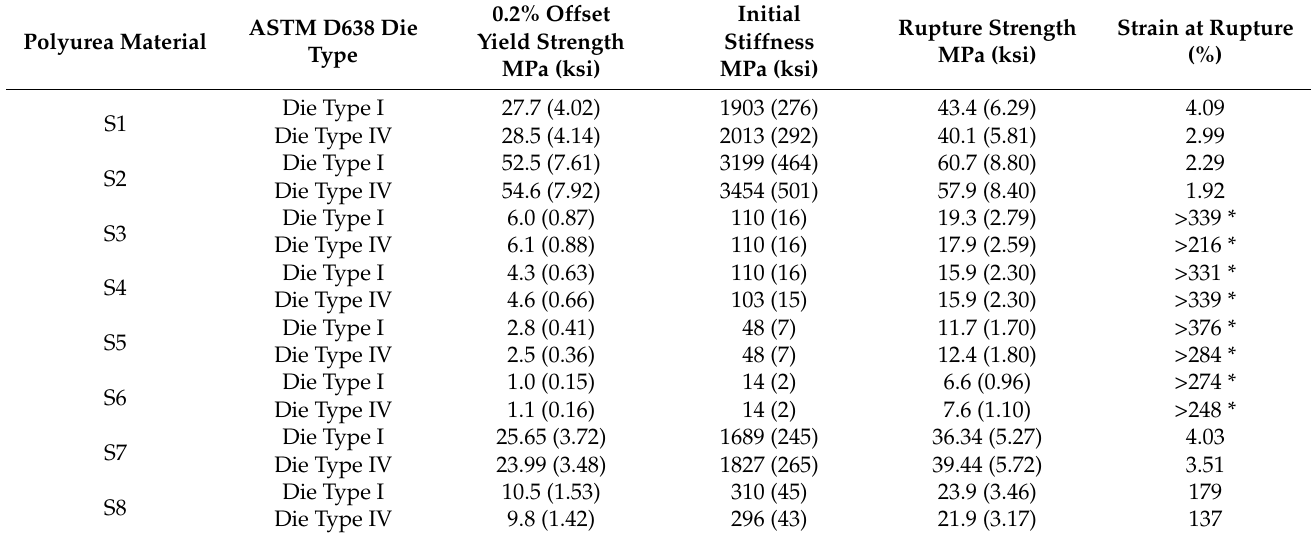
Table 4. Tensile tests results summary for eight different tested commercial